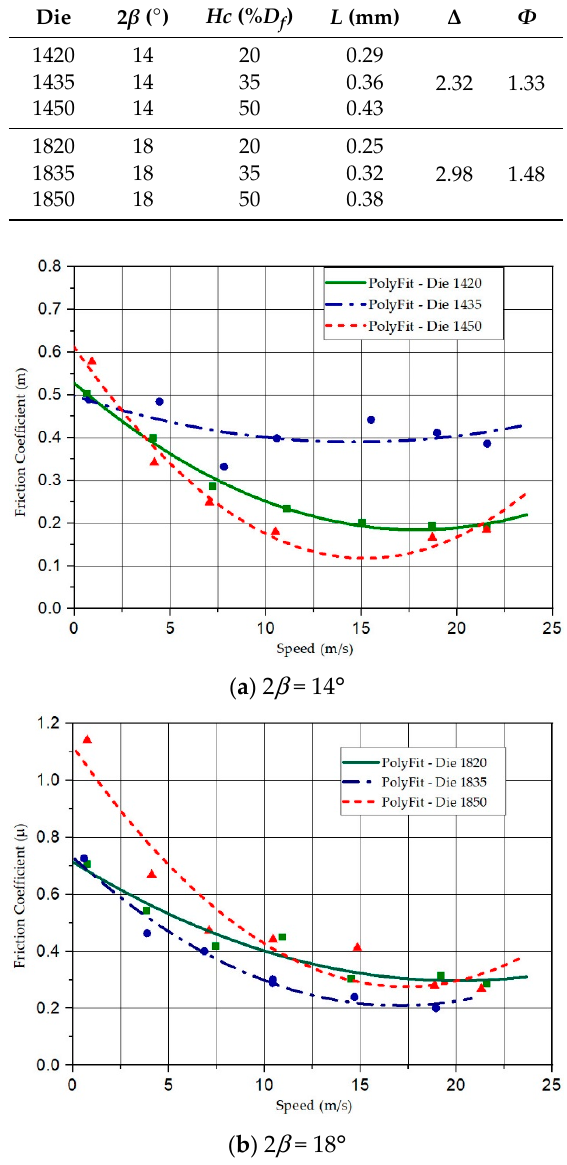
Figure 2. The coe ffi cient of friction as a function of the drawing speed for di ff erent die geometries in Figure 2. The coefficient of friction as a function of the drawing speed for different die geometries in terms of bearing zones and die angles. terms of bearing zones and die